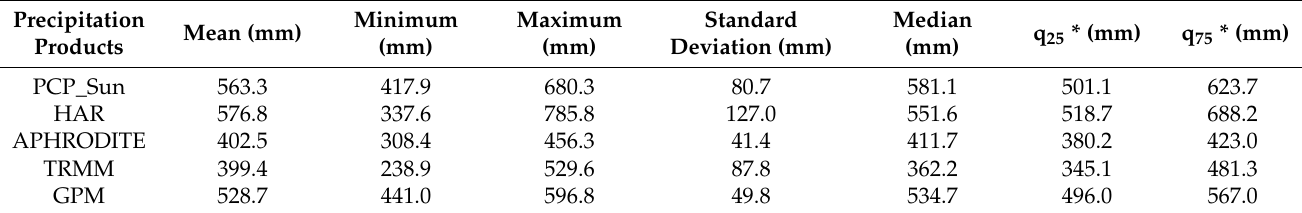
Table 5. Statistics of annual precipitation at basin scale over the